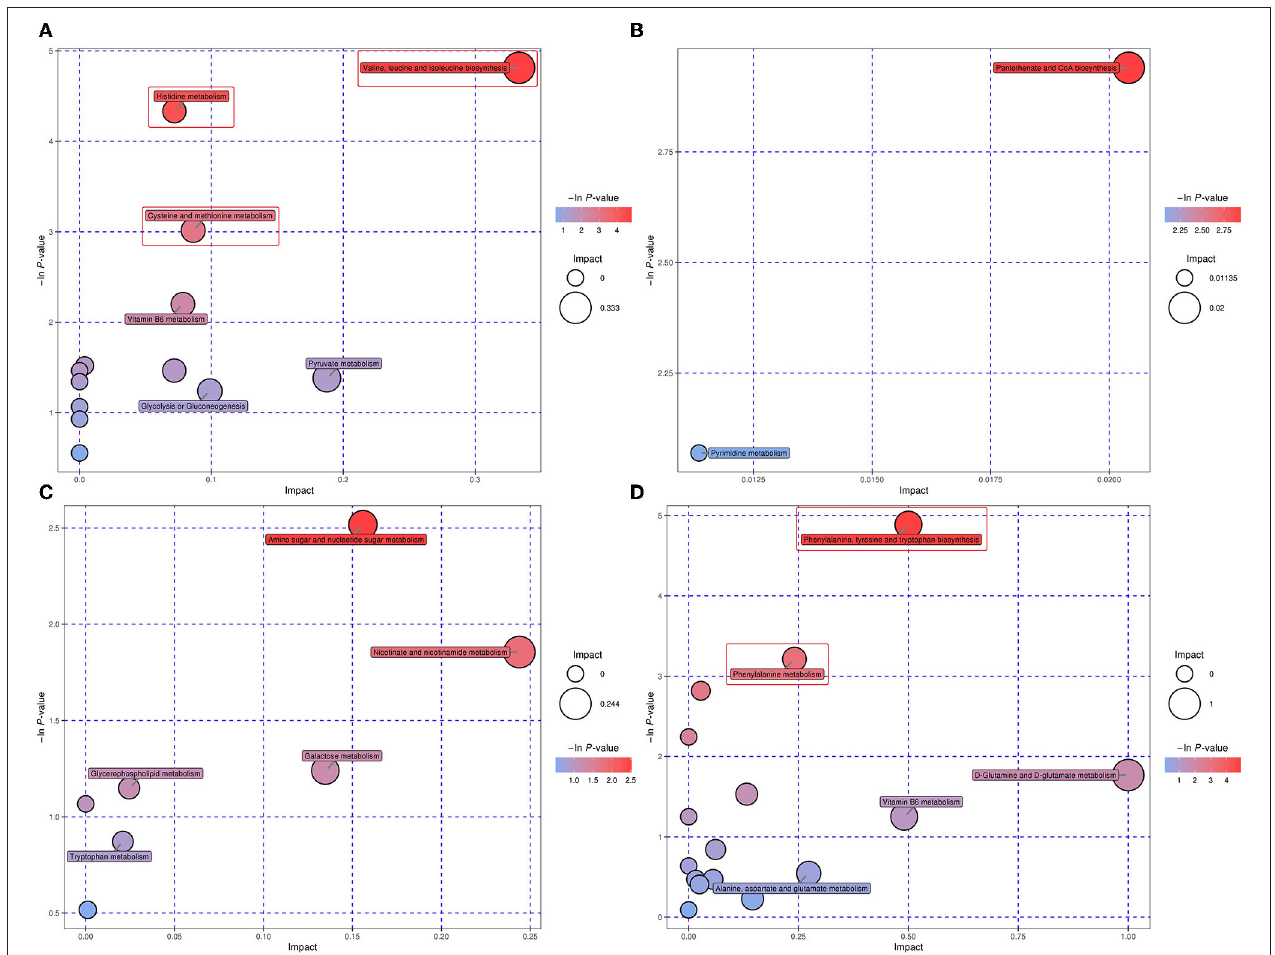
FIGURE 4 | Bubble plot demonstrating the differential metabolic pathways between the two dietary treatments in rumen liquid (A) , plasma (B) , milk (C) , and urine (D) . The x-axis symbolizes the pathway impact, whilst the y-axis represents the pathway enrichment. The bubbles with larger sizes and darker colors represent pathways with higher impact values and higher enrichment. The red frame indicates that the pathway inside was identified with an enrichment p < 0.05.